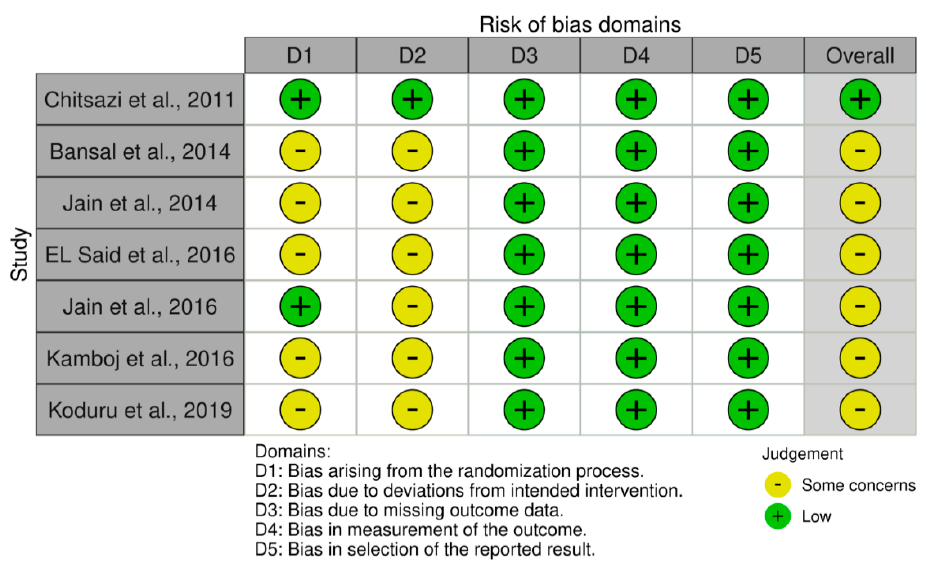
Figure 2. Bias assessment: RoB2 tool for included RCTs.